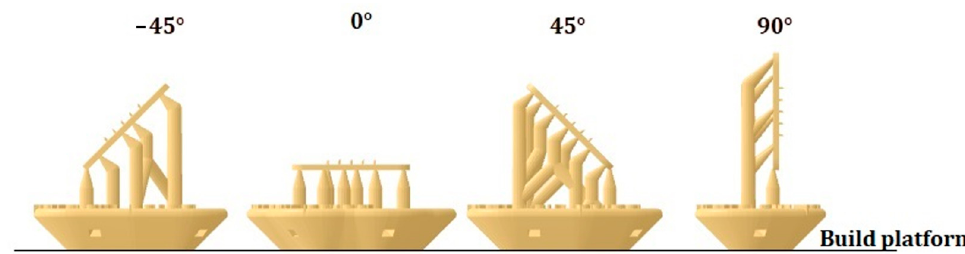
Figure 3. Printing angles concerning the build platform.